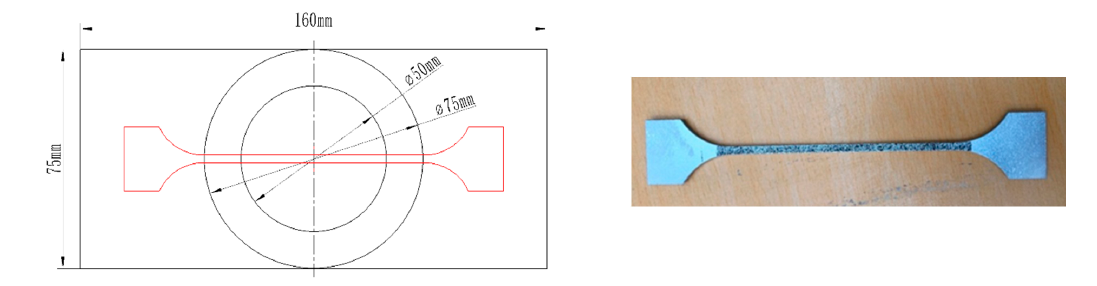
Figure 8. Tensile specimen after speckle treatment.